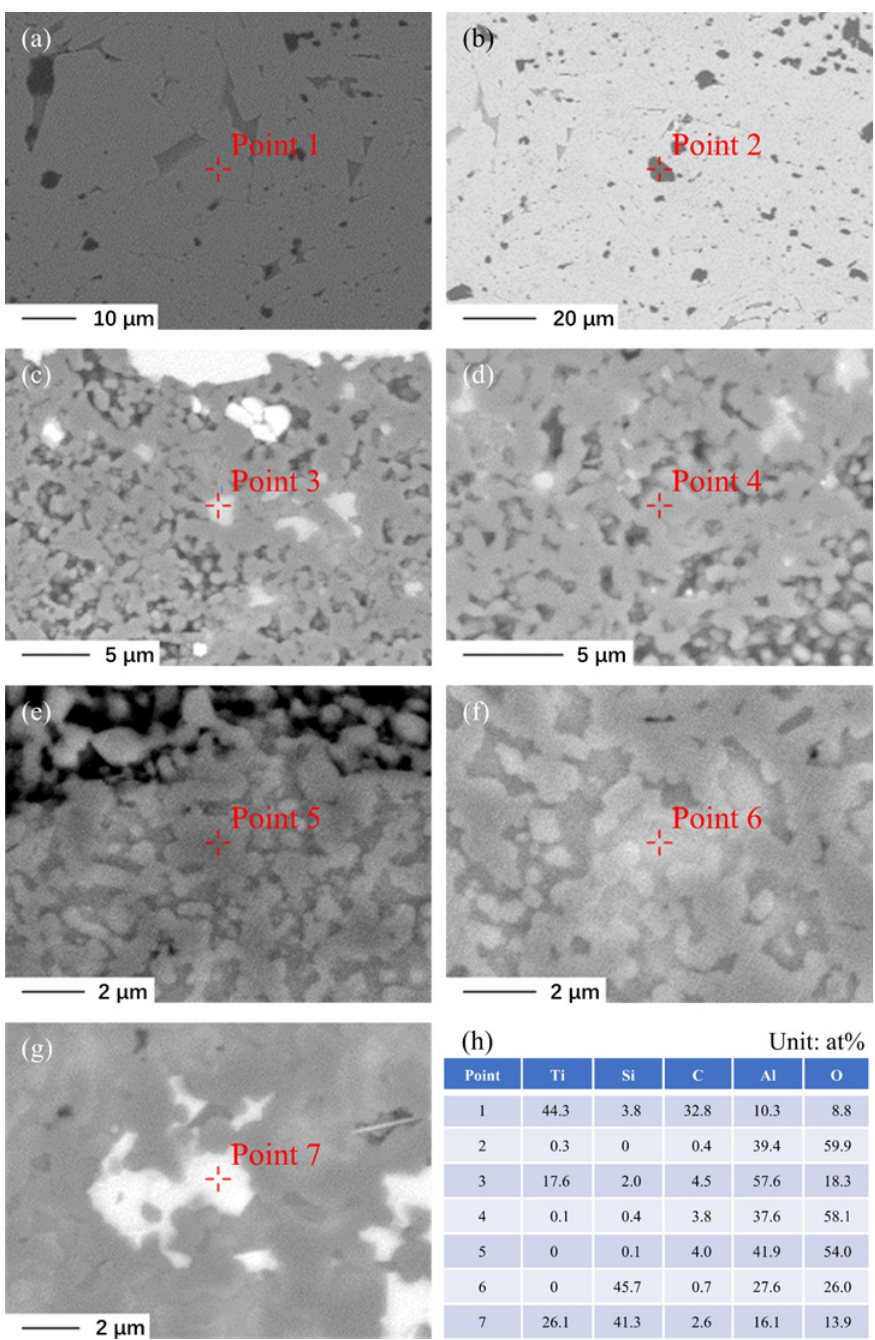
Fig. 6 Micrographs of (a, b) MAX phase layer, (c, d) Al 2 O 3 layer, and (e–g) Al–Si–O layer; (h) EPMA point scan results for points